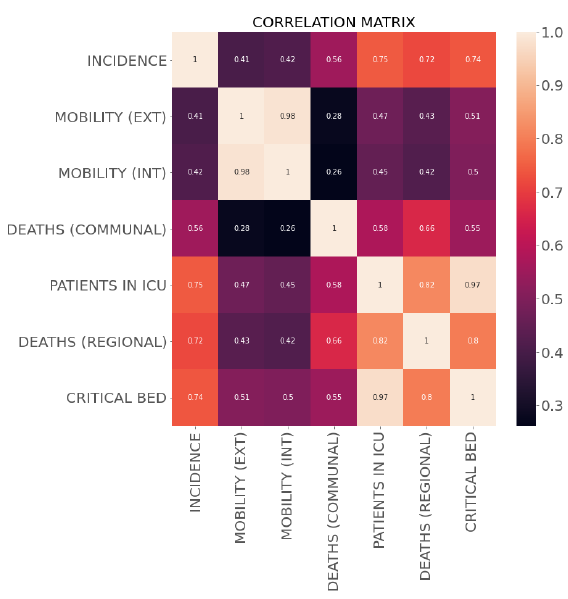
Figure 6. Boxplot for commune and regional features.